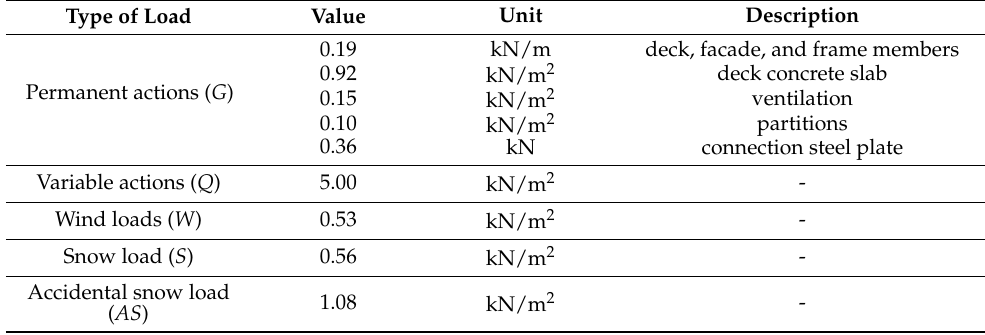
Table 1. Loads considered in the preliminary structural analysis.